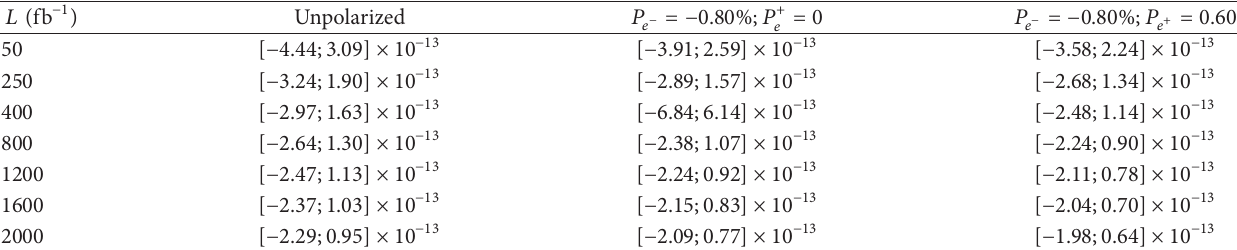
Table 8: Sensitivity of 𝑓 𝑇0 /Λ 4 at 95% CL for √𝑠 = 3 TeV in units of GeV −4